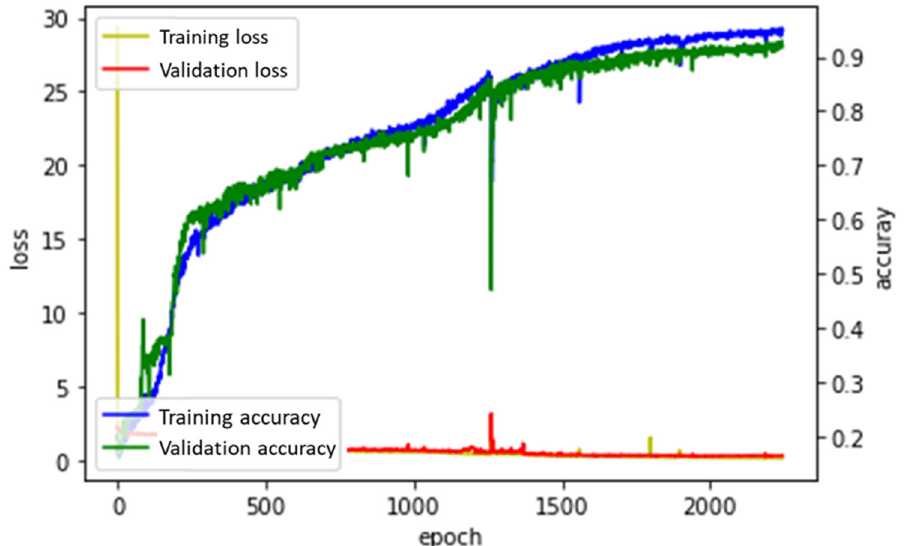
Figure 7. Performance graph by the Adagrad optimizer.